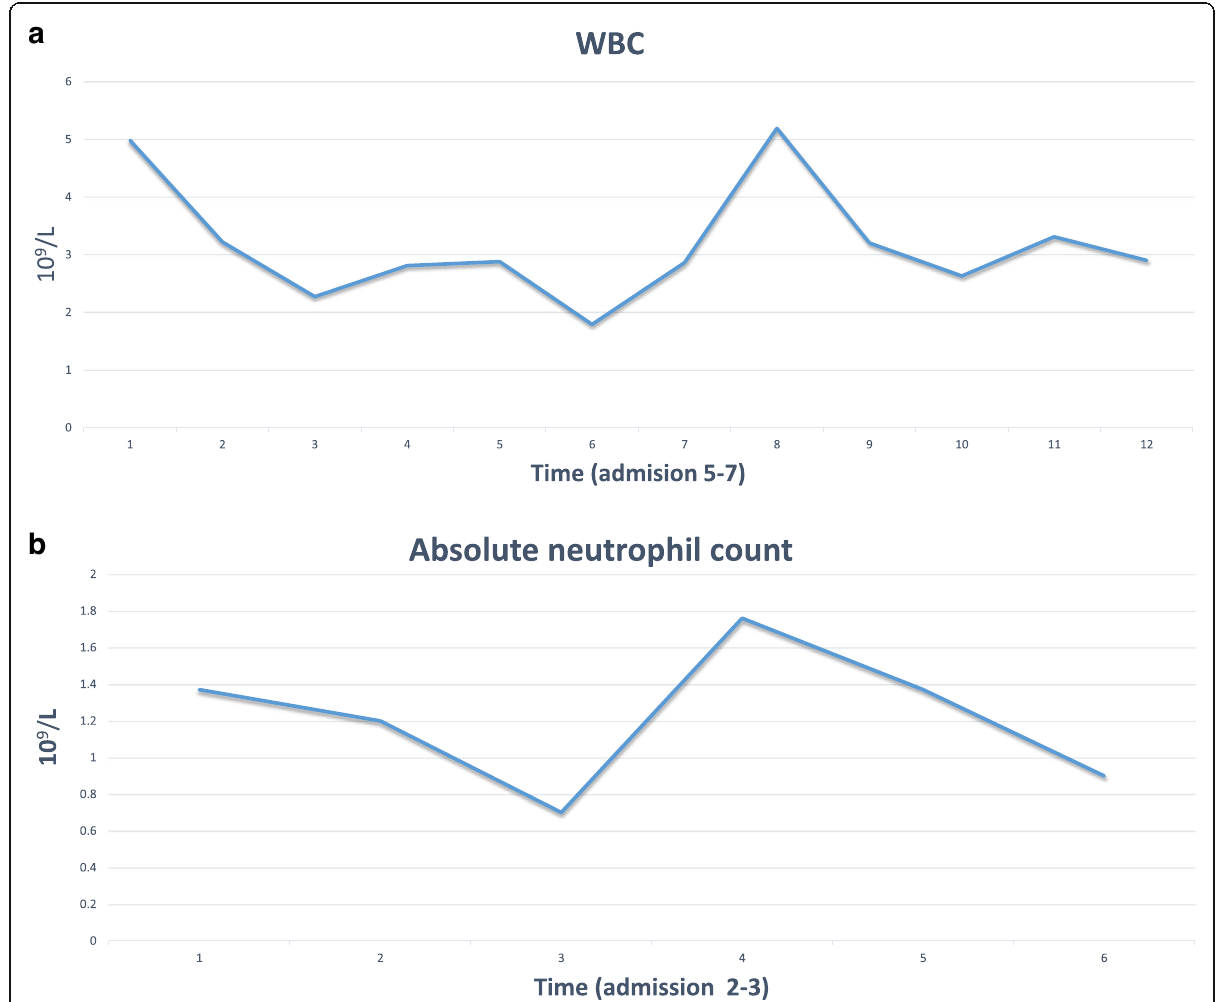
Fig. 1 a A flow chart for leucocytic count (WBC) showing cyclic leucopenia prior COVID-19 infection, and a leucocytic count lower than her usual baseline during this admission, which started to recover by discharge. b A flow chart for absolute neutrophilic count showing neutropenia during COVID-19 infection, which started to recover by